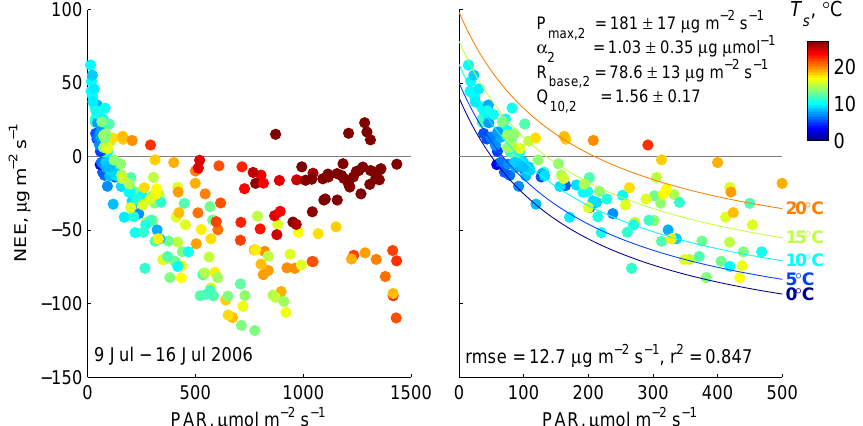
Fig. 3. NEE flux measurements during period 9 July–16 July, 2006 (i.e. days 190–197), plotted against PAR and coloured according to surface temperature. The right-hand panel provides an example of the bulk flux partition model (i.e. Eq. 3) in the low PAR range during this period with five of the fitted isotherms provided for comparison. Note the change in the plotting range of the x-axis between the two images.